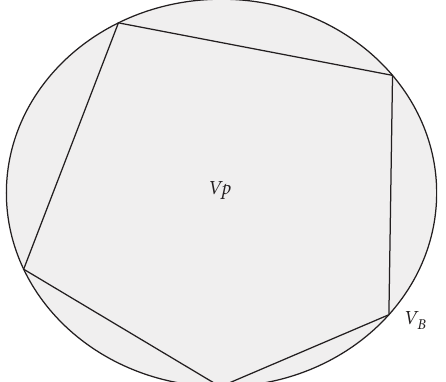
Figure 2: Roundness of aggregate